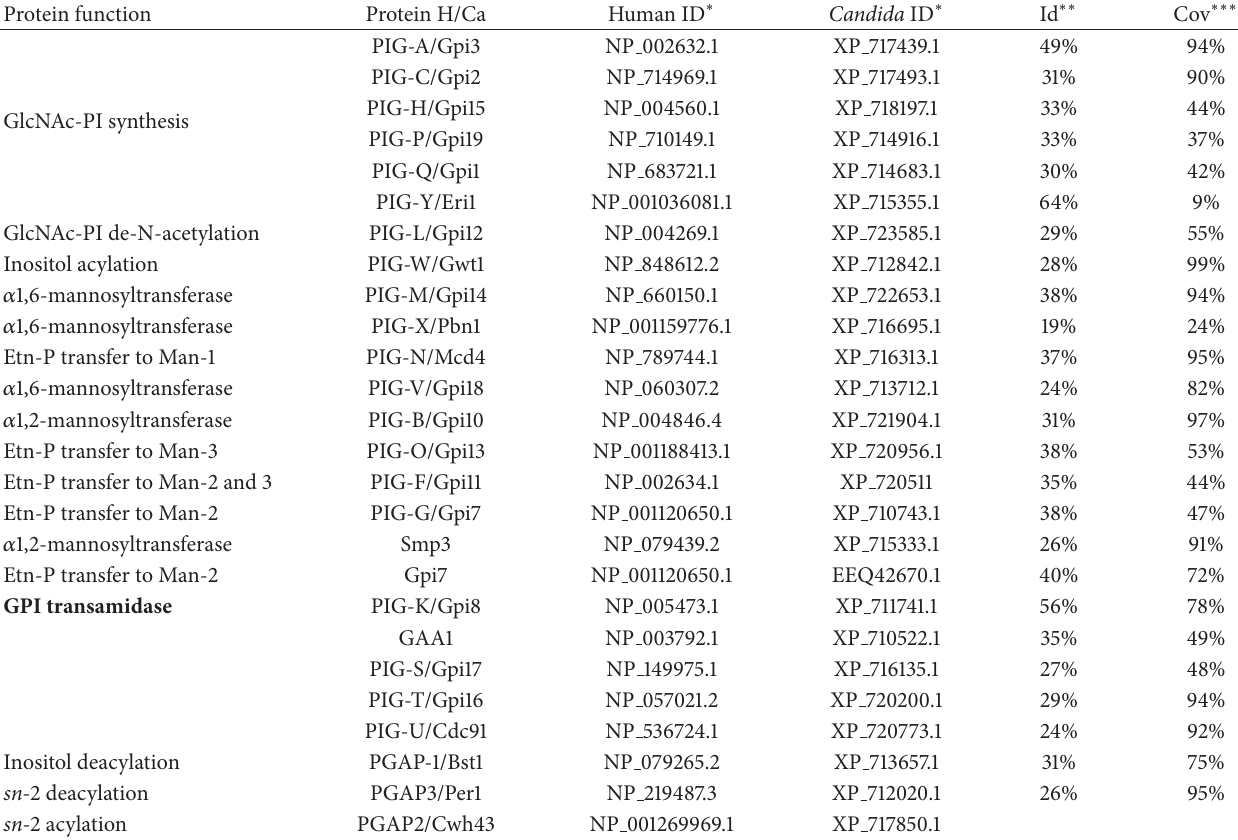
Table 4: Human and C. albicans homologous proteins involved in GPI glycosylation. Protein